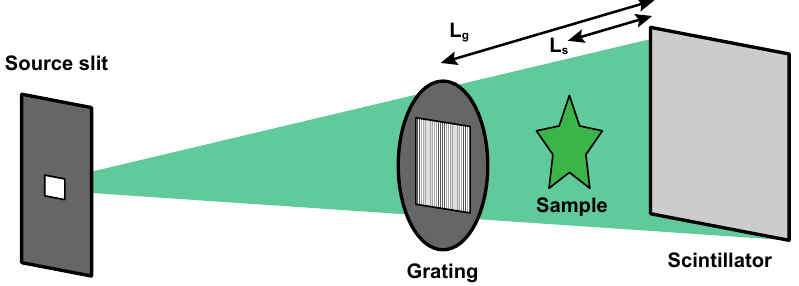
Figure 1. Sketch of the instrumental